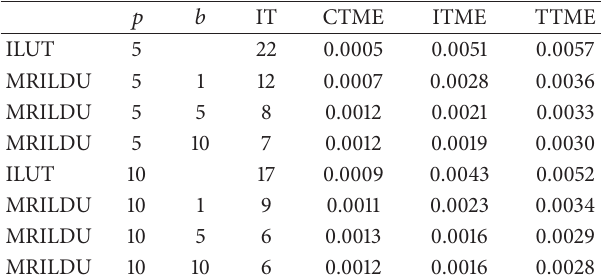
Table 13: Iteration results for MAT17.